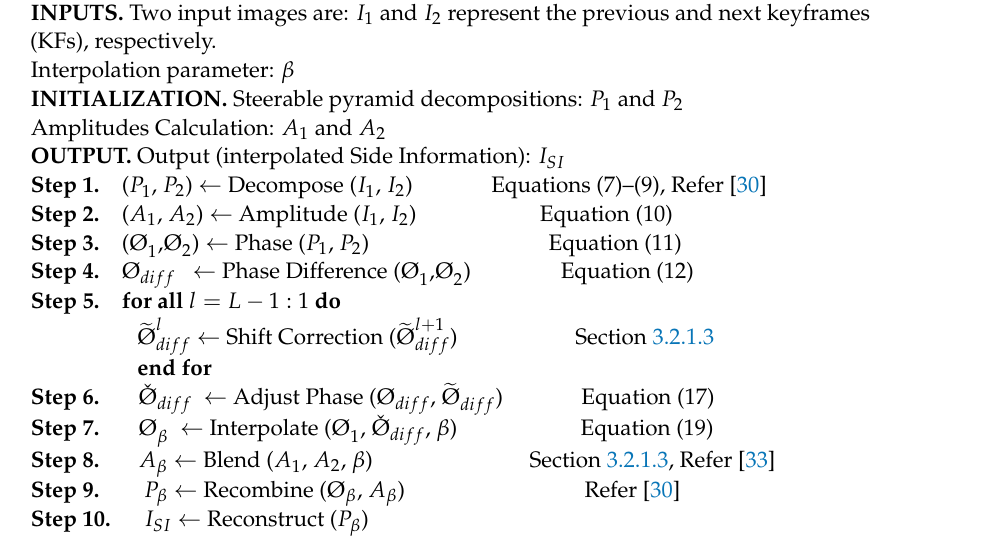
Algorithm 1 Side Information Generation with Phase Interpolation